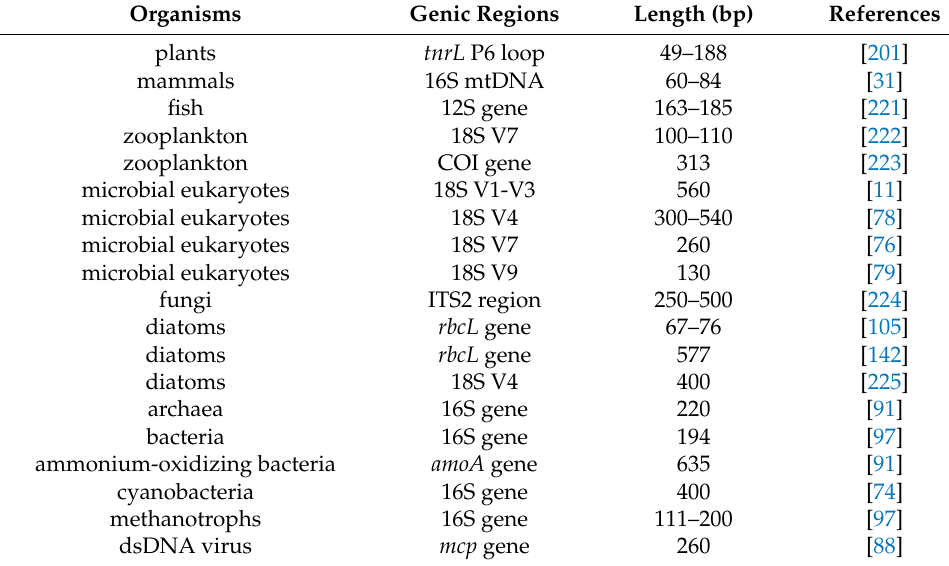
Table 1. Recommended DNA markers for sedaDNA research. For sedaDNA applications, we recommend that markers of <150 bp are targeted (see Section 3.9). Amplicon length includes primer binding sites. Microbial eukaryotes include unicellular